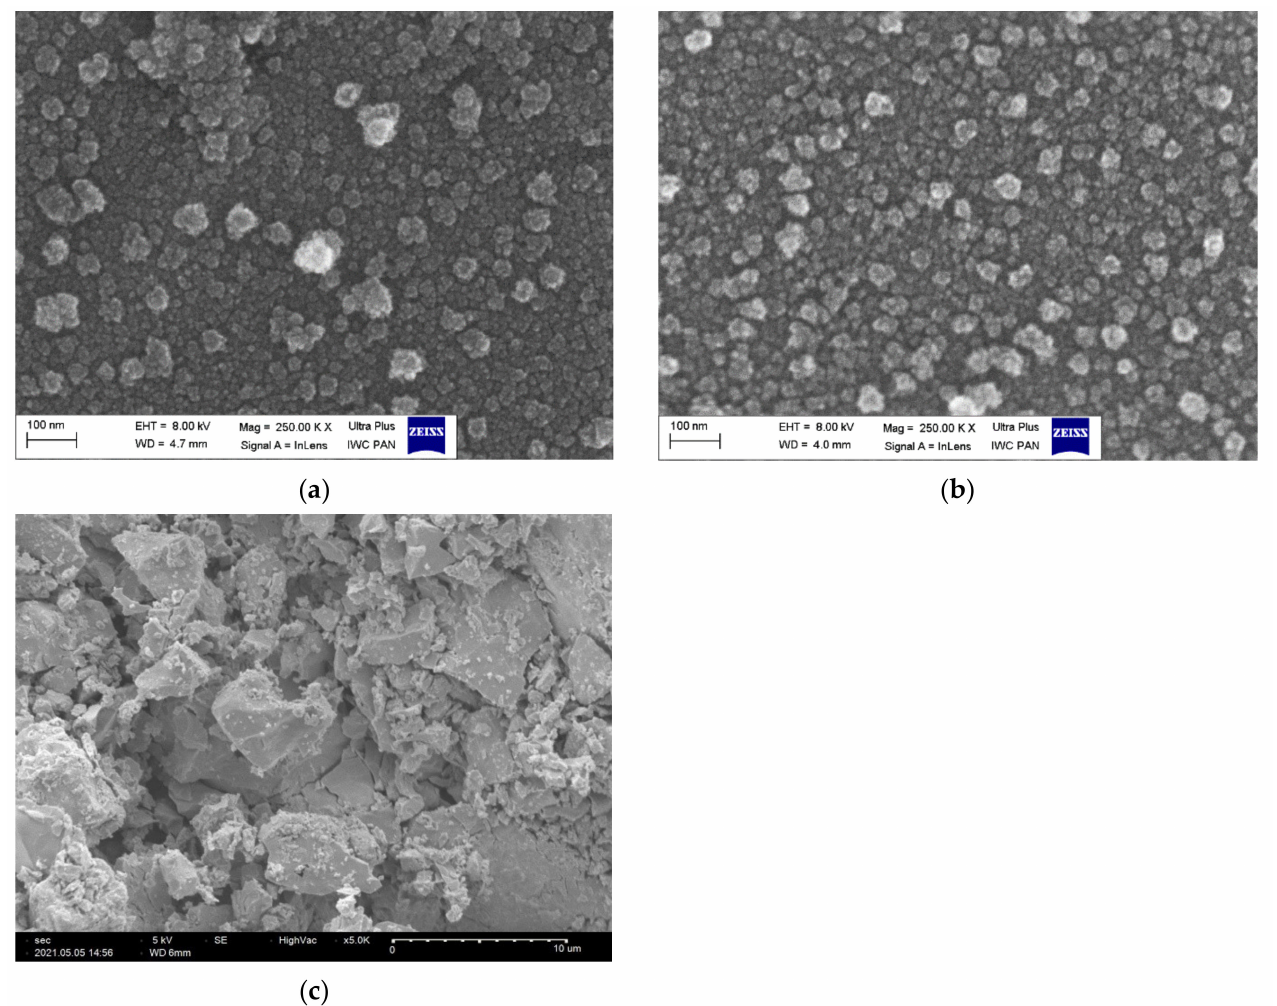
Figure 4. SEM micrographs of the received samples: ( a ) melted in a ceramic crucible at 1000 ◦ C, quenched by twin rollers method at 1000 RPM; ( b ) melted in ceramic crucible at 1000 ◦ C, quenched by twin rollers method at 800 RPM; ( c ) melted in PtIr crucible at 1000 ◦ C, quenched by twin rollers method at 1000